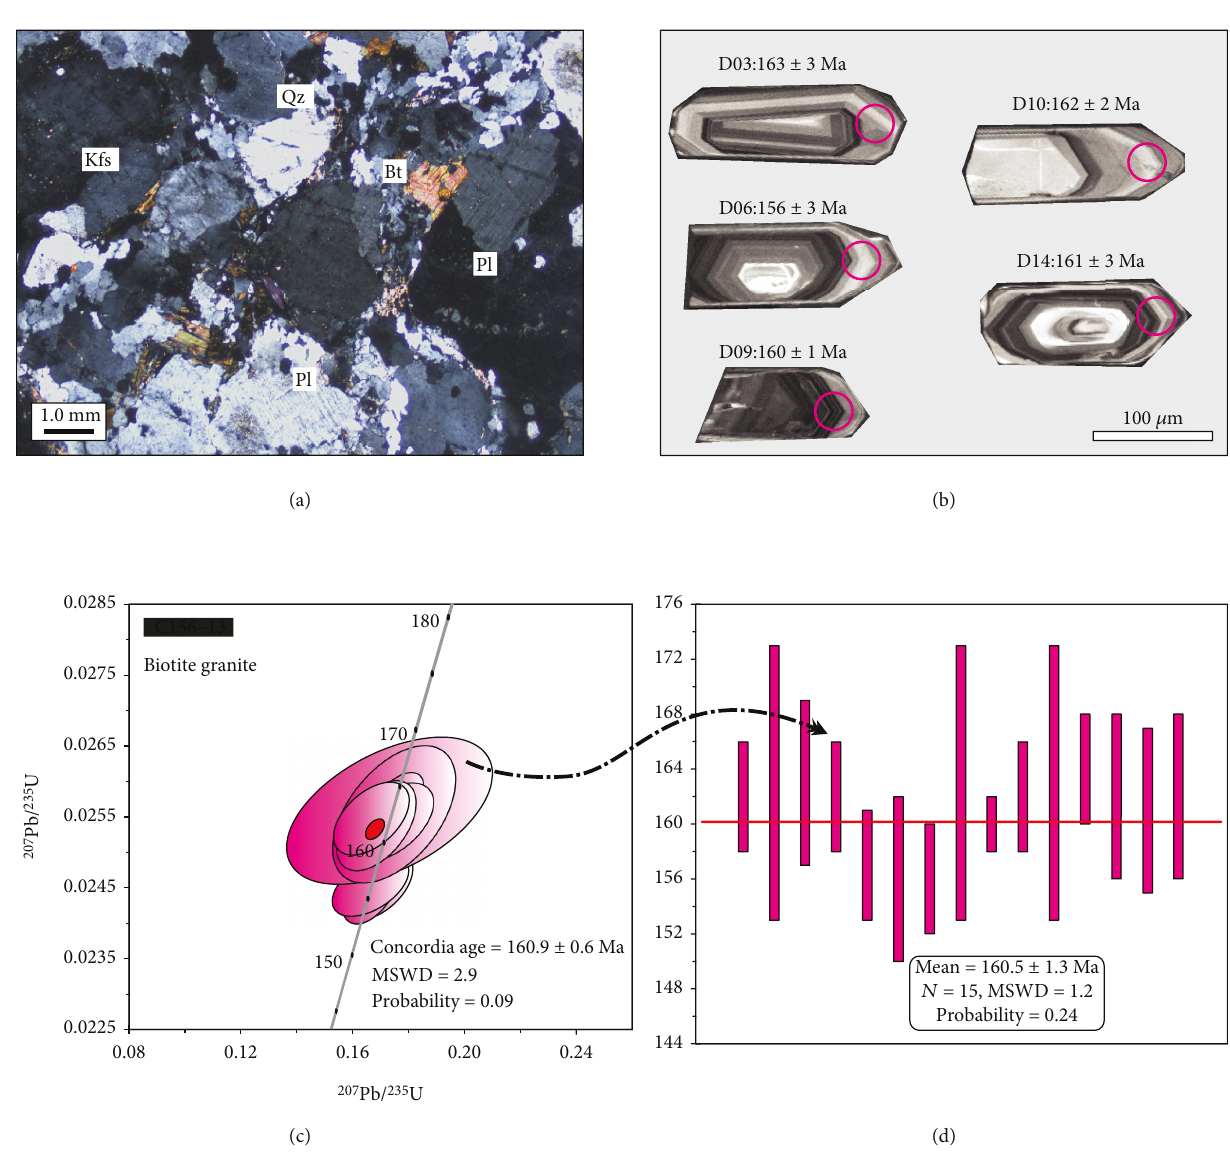
Figure 6: (a) The Linglong biotite granite (C156-13) under polarized light; (b) representative zircon CL images of the biotite granite; (c) U – Pb concordia diagrams of the biotite granite; (d) the 206 Pb/ 238 U-weighed mean age of the biotite